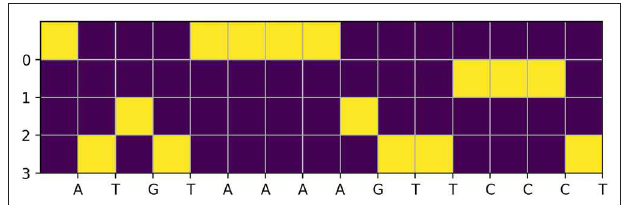
FIGURE 1 | An example of one-hot encoded vector for a DNA fragment of length